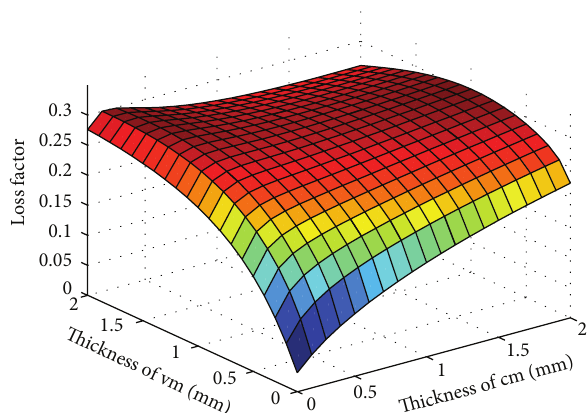
Figure 17: Influence of thickness on the loss factor in 7-layer struc- ture.